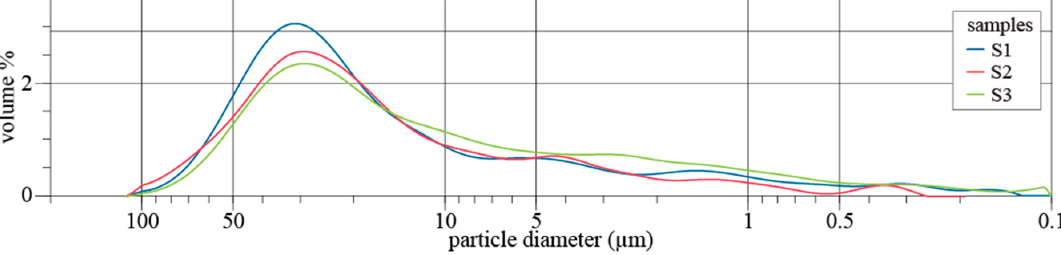
Figure 3. Size distribution (%) of road dust particles, Ø < 106 µm.